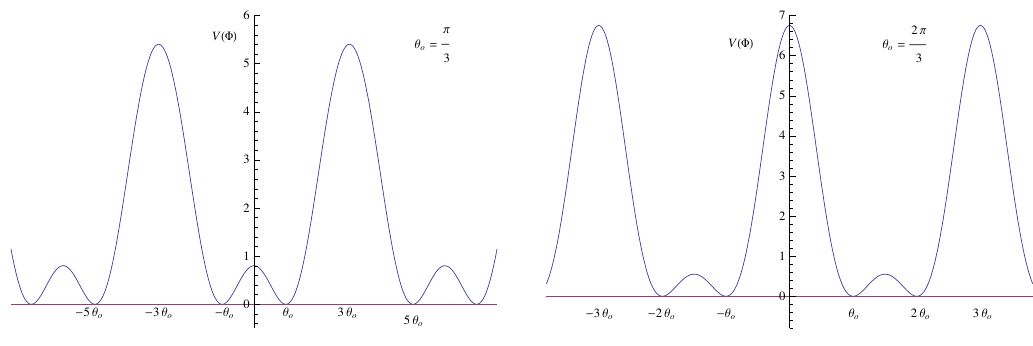
Figure 1 . The plots of the potential V 1 (Φ) in (3.64) for A 3 = 0 . 1 , z = 4 . 5 , β = 1 . Left figure for θ 0 = π and vacua (2 n + 1) θ o , n ∈ ZZ . Right figure for θ 0 = 2 π 3